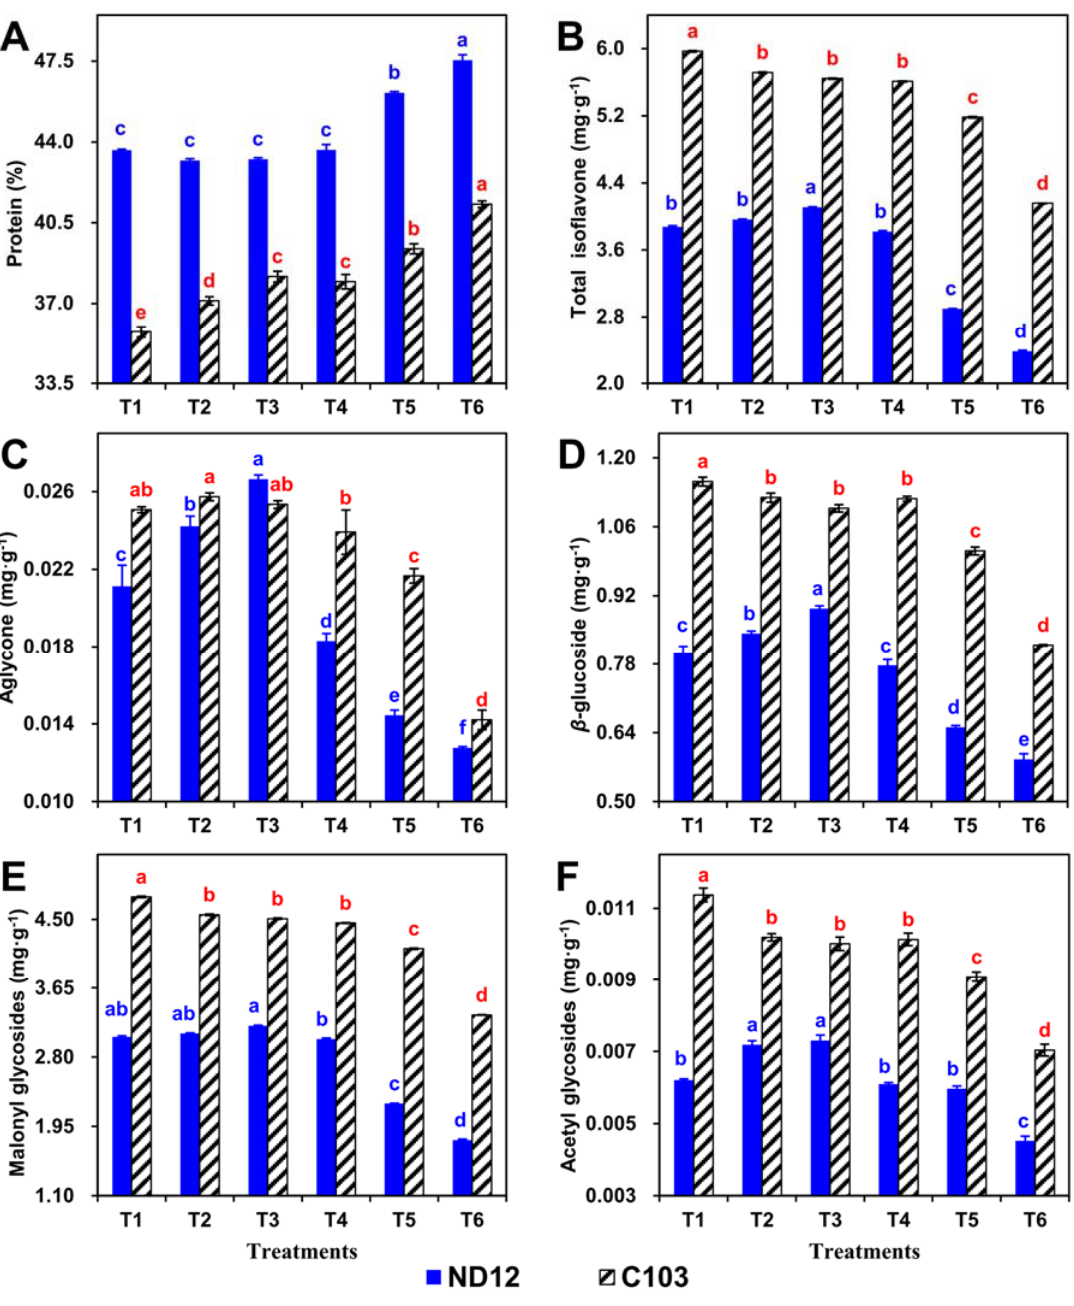
Figure 6. Effect of split ‐ root water imbalance treatments on protein and isoflavones of two soybean genotypes ND12 (drought resistant) and C103 (drought susceptible). ( A ) Protein %, ( B ) total isoflavone mg · g − 1 , ( C ) aglycone mg · g − 1 , ( D ) β -glucoside mg · g − 1 , ( E ) malonyl glycoside mg · g − 1 , ( F ) acetyle glycoside mg · g − 1 . (Means ± SE), same small letters are not significantly different at p < 0.05. T1, 100/100; T2, 100/50; T3, 100/20; T4, 50/50; T5, 50/20; T6, 20/20.